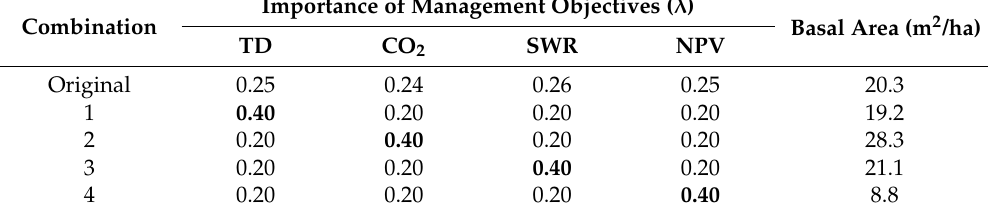
Table 3. Sensitivity analysis of the compromise solution to changes in the relative importance of management objectives. Bold numbers indicate the largest relative contribution (evaluation based on p =